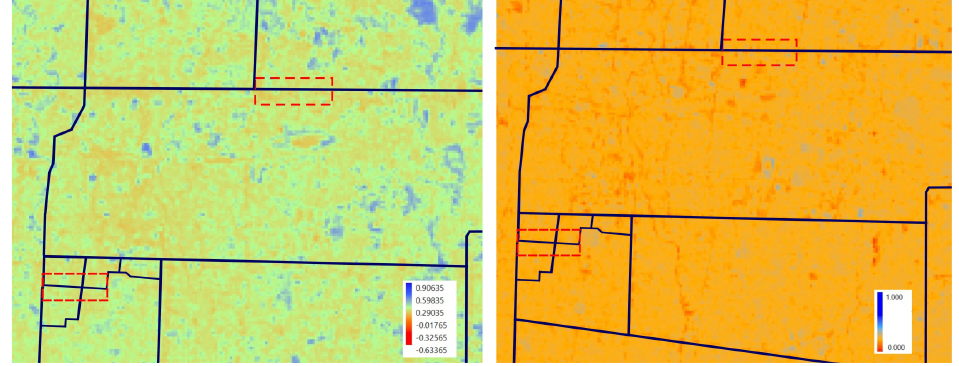
Fig. 8. Albedo maps retrieved from Landsat-8 OLI TIRS on May 5 at 02:47:15 (left) and August 25 at 21:50:13